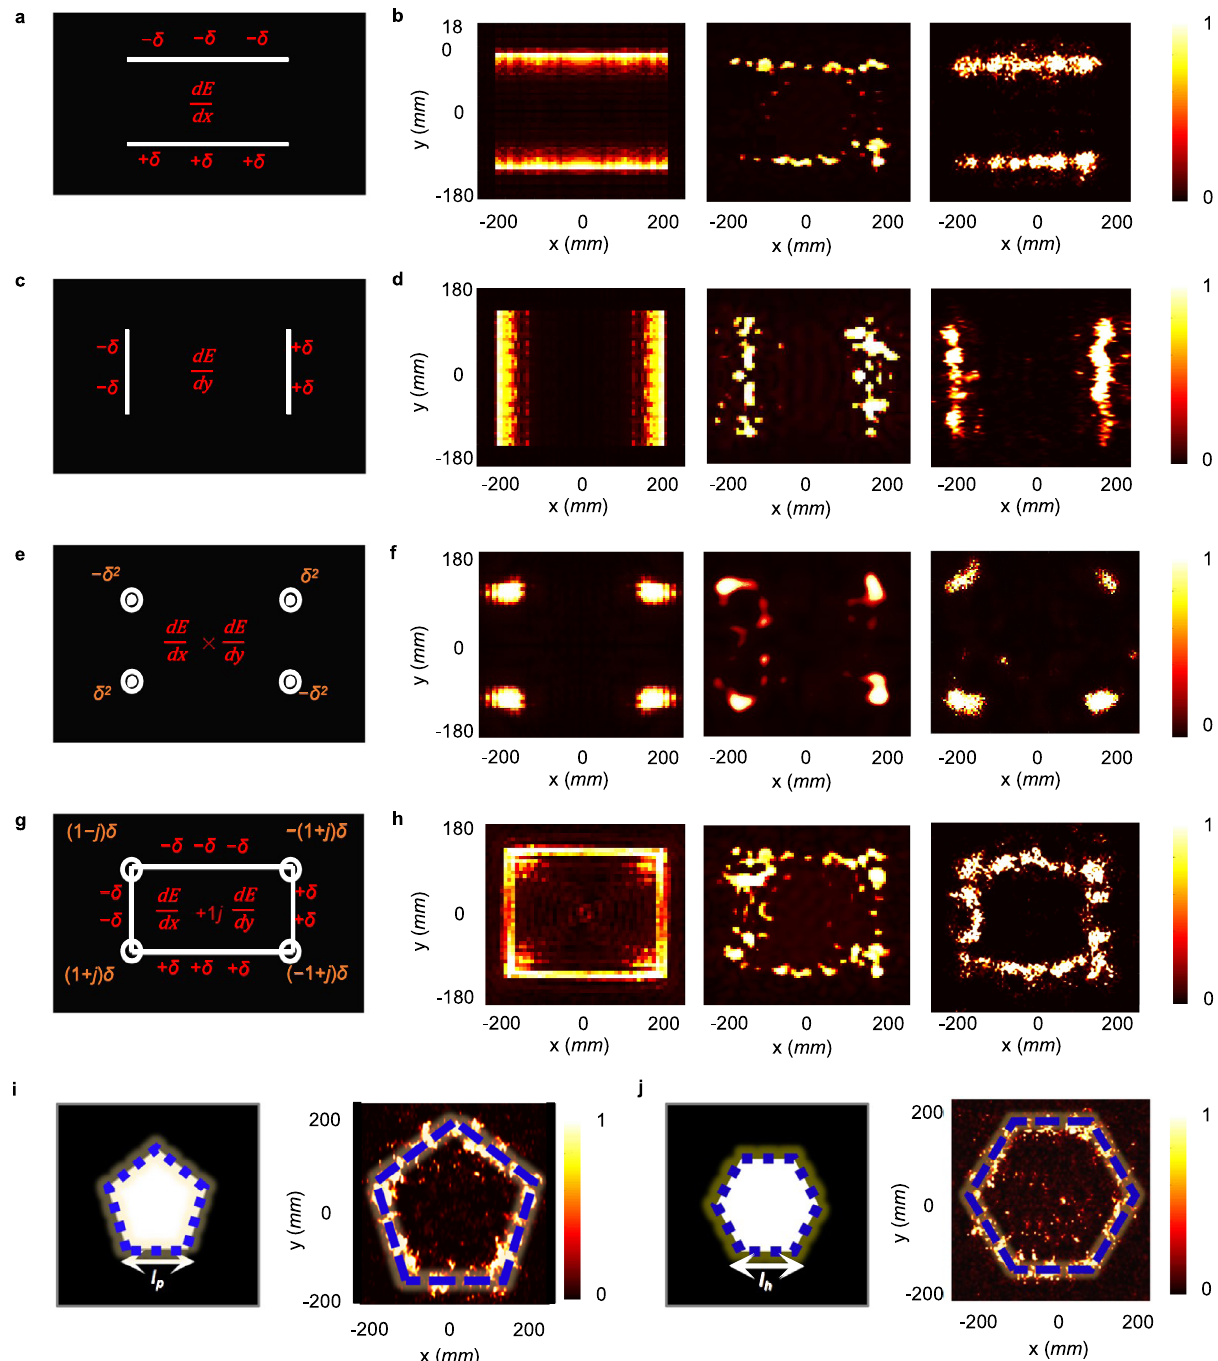
Fig. 4 The fi rst-order derivative operation. a Schematic diagram and b theoretical calculations (left), numerical simulations (middle) and experimental results (right) of the normalized electric fi eld intensity distribution at the output focal length f 2 = 100 mm and 10 GHz working frequency for 1D-edge detection along x -axis. c Schematic diagram and d theoretical calculations (left), numerical simulations (middle) and experimental results (right) of the normalized electric fi eld intensity distribution at the output focal length f 2 = 100 mm and 10 GHz working frequency for 1D-edge detection along y -axis. e Schematic diagram and f theoretical calculations (left), numerical simulations (middle) and experimental results (right) of normalized electric fi eld intensity distribution at the output focal length f 2 = 100 mm and 10 GHz working frequency for vertex detection. g Schematic diagram and h theoretical calculations (left), numerical simulations (middle) and experimental results (right) of normalized electric fi eld intensity distribution at the output focal length f 2 = 100 mm and 10 GHz working frequency for 2D-edge detection. i The input image of regular pentagon (left) with l p = 210 mm and output experimental results (right) of normalized electric fi eld intensity distribution at the output focal length f 2 = 100 mm and 10 GHz working frequency for 2D- edge detection. j The input image of regular hexagon (left) with l h = 175 mm and the output experimental results (right) of normalized electric fi eld intensity distribution at the output focal length f 2 = 100 mm and 10 GHz working frequency for 2D-edge